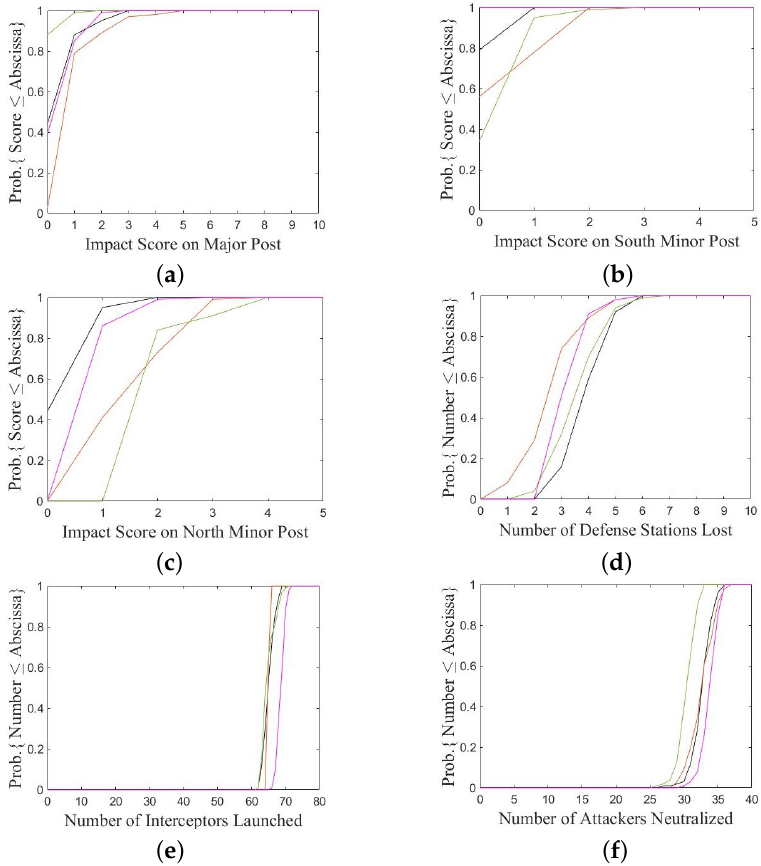
Figure 10. CDF of ( a ) impact score on major post; ( b ) impact score on south post; ( c ) impact score on north post; ( d ) number of lost defense stations; ( e ) number of launched interceptors; ( f ) number of lost attackers, against slant attack formation, black: ζ 1 , orange: ζ 2 , green: ζ 3 , purple: ζ 4